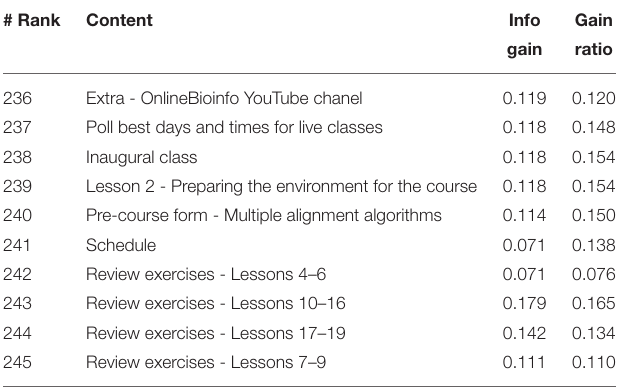
TABLE 4 | The bottom 10 course resources correlated with course completion.